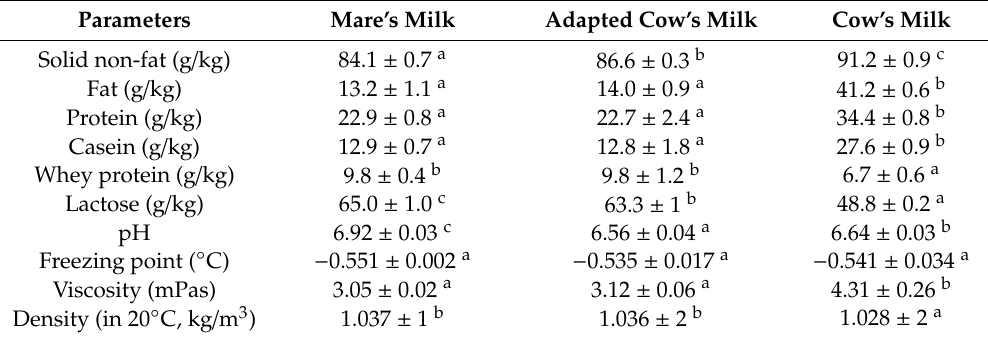
Table 1. Gross composition and physicochemical characteristics of mare’s milk, cow’s milk adapted to mare’s milk composition, and cow’s